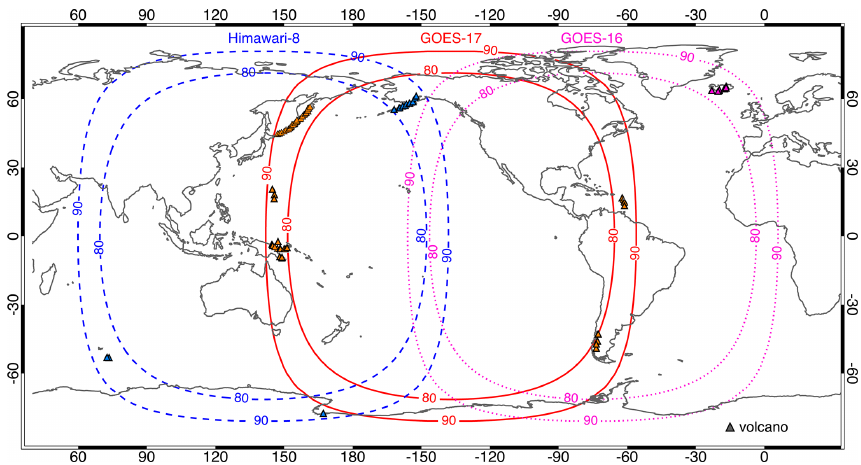
Figure 2. Limb area between the 80 ◦ and 90 ◦ view zenith angle isolines of the GOES-16 (dotted magenta), GOES-17 (solid red), and Himawari-8 (dashed blue) full disk. Triangles indicate volcanoes that erupted within the limb areas in the past 100